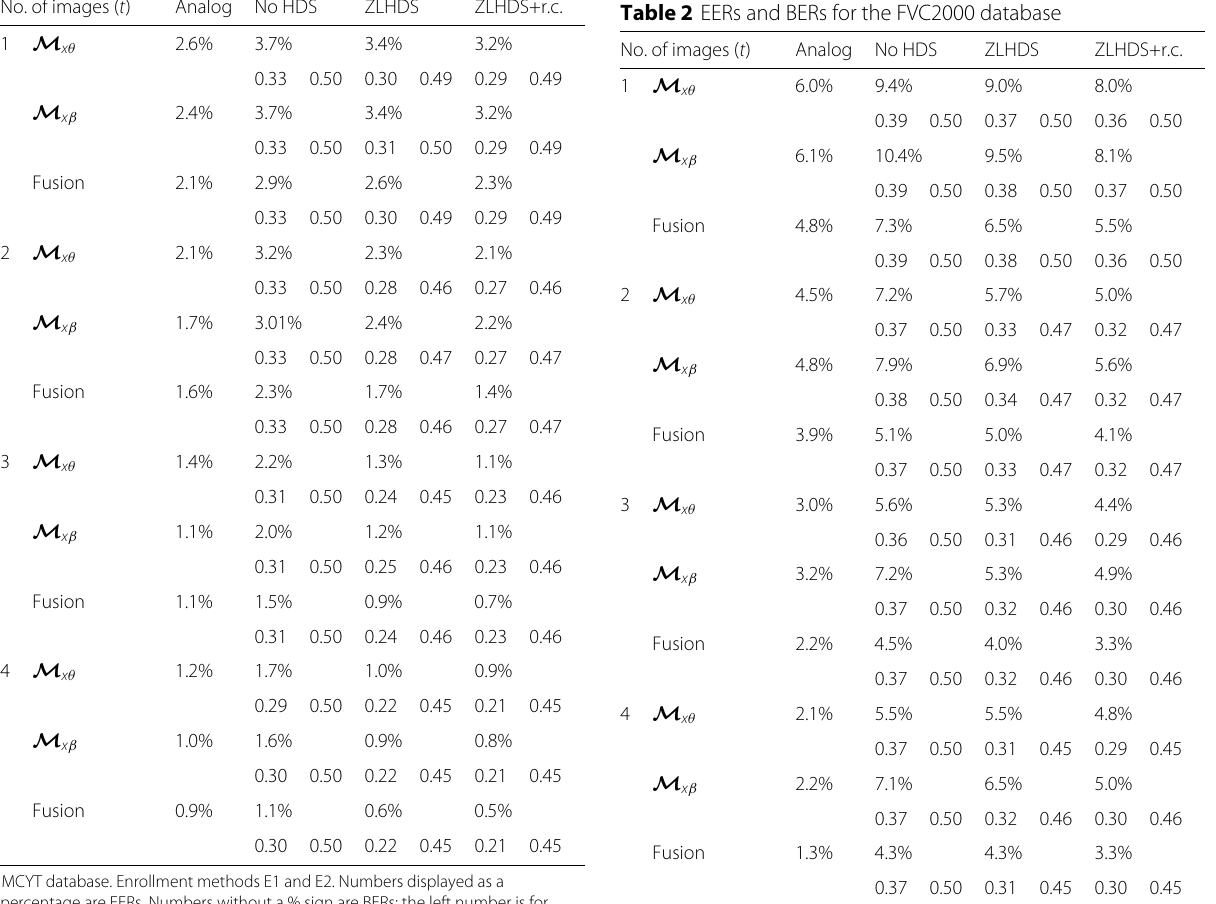
Table 1 Equal error rates and bit error rates